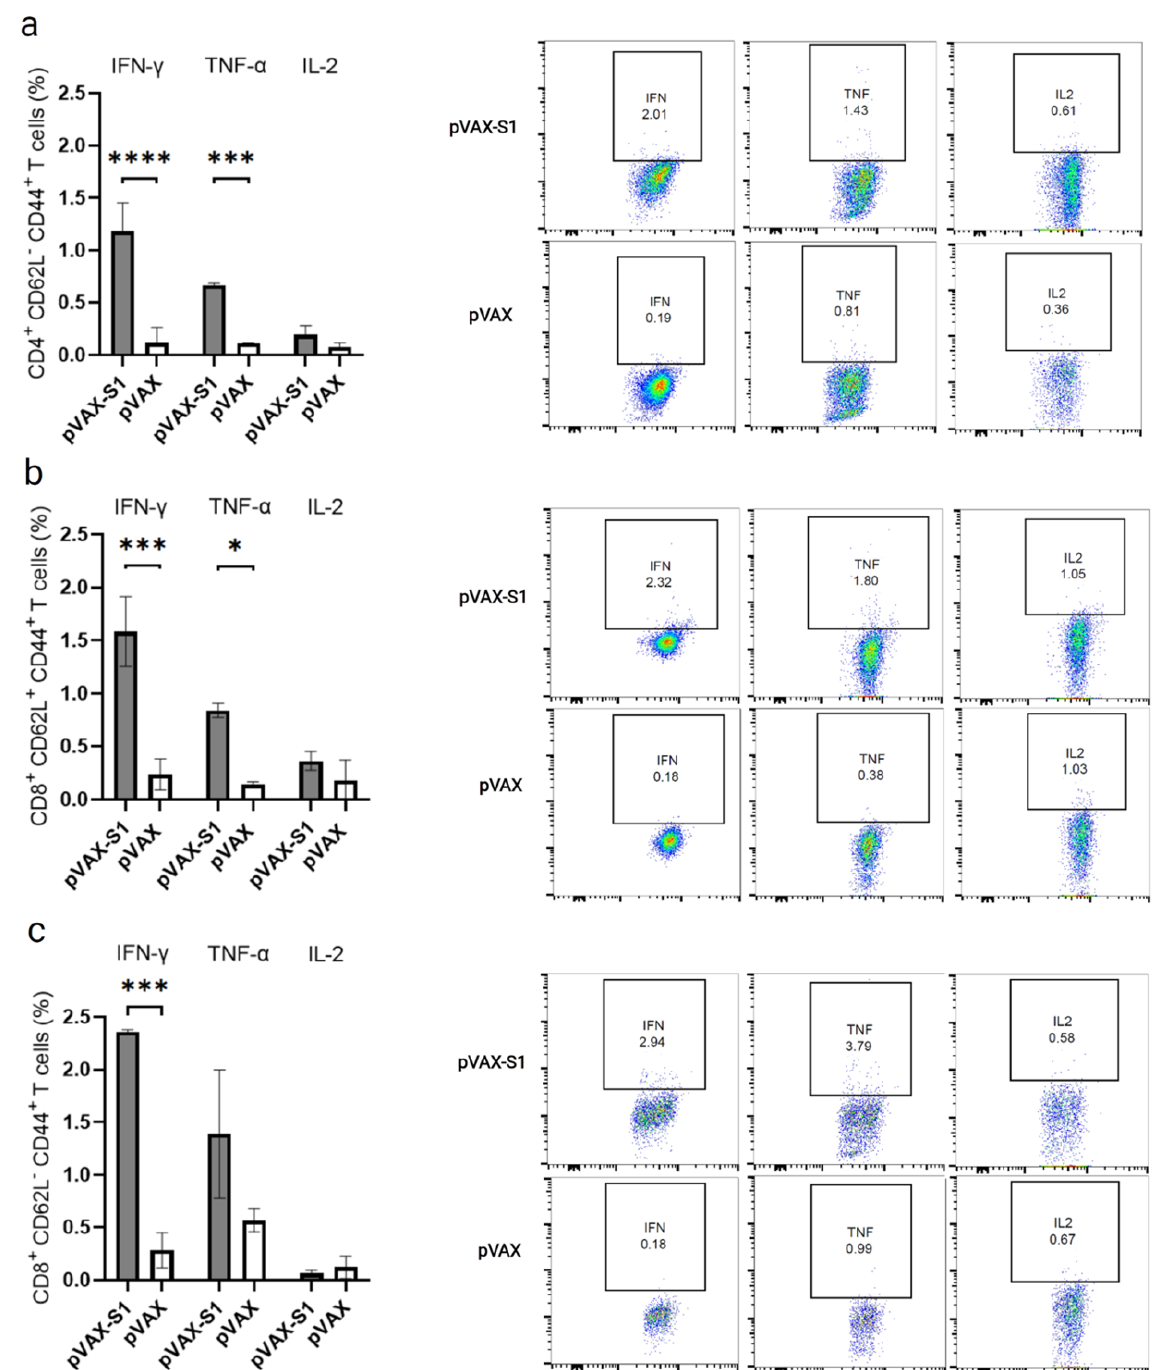
Figure 3. Overall memory T cells response in immunized mice. Histograms and FACS plots display overall IFN- γ , TNF- α and IL-2 expression from ex vivo re-stimulated ( a ) memory CD4 (CD4 + CD62L − CD44 + T cells), ( b ) central memory CD8 (CD8 + CD62L + CD44 + T cells) and ( c ) effector memory CD8 (CD8 + CD62L − CD44 + T cells). Data in histograms are shown as percentages of induced cytokines from peptides-stimulated cells after subtracting levels produced by unstimulated splenocytes from each mouse. Representative FACS plots are shown. Data are shown as mean ± SD for each group from one experiment ( n = 3). Statistical significance is reported as *, p ≤ 0.05, ***, p ≤ 0.001, and ****, p ≤ 0.0001.